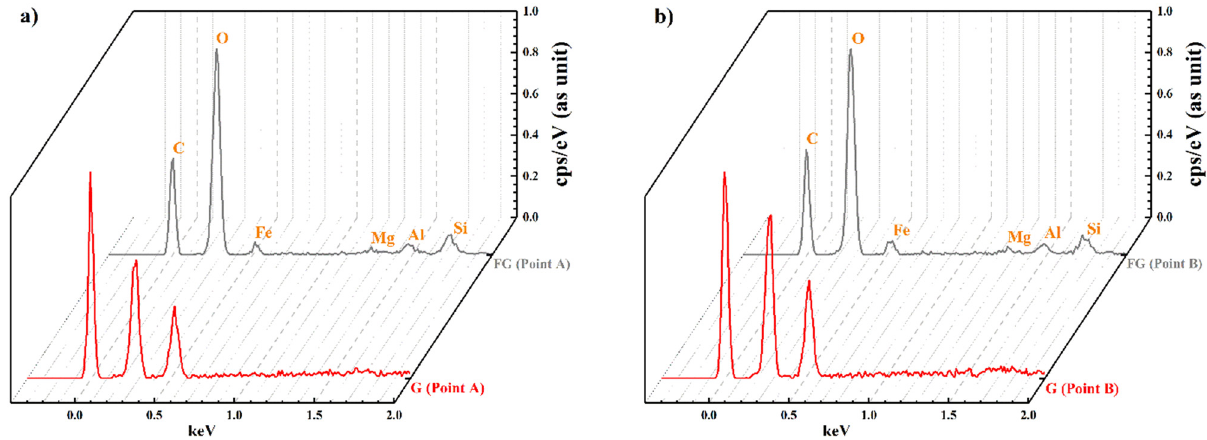
Figure 7: EDX pattern of fl ake graphite and graphene for ( a ) point A and ( b ) point B.